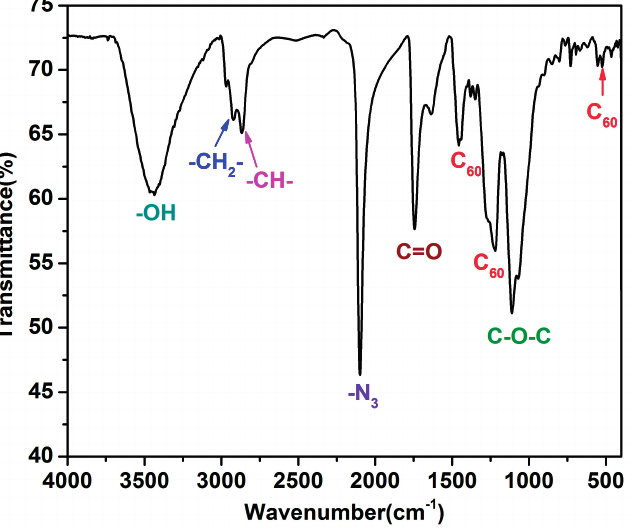
Figure 1. Fourier transform infrared (FTIR) spectrum of C 60